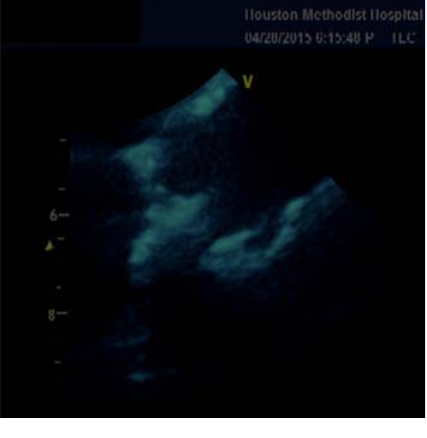
Figure 2: Aortic valve vegetation in parasternal long axis view.